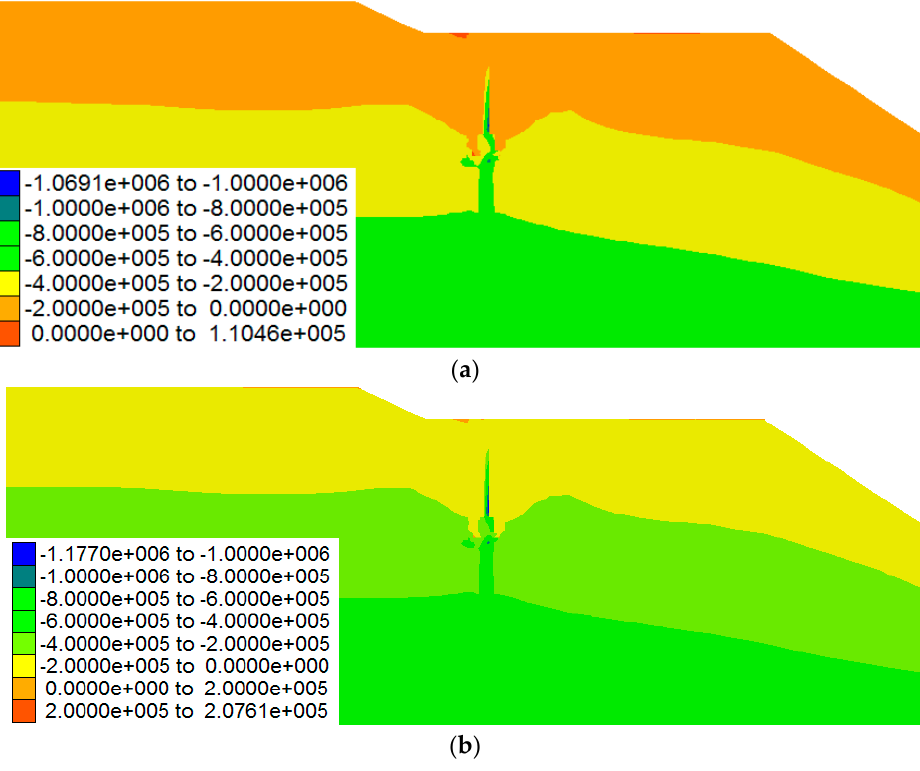
Figure 16. Comparison of maximum principal stress of monitoring surface. ( a ) 1. ( b ) 2.